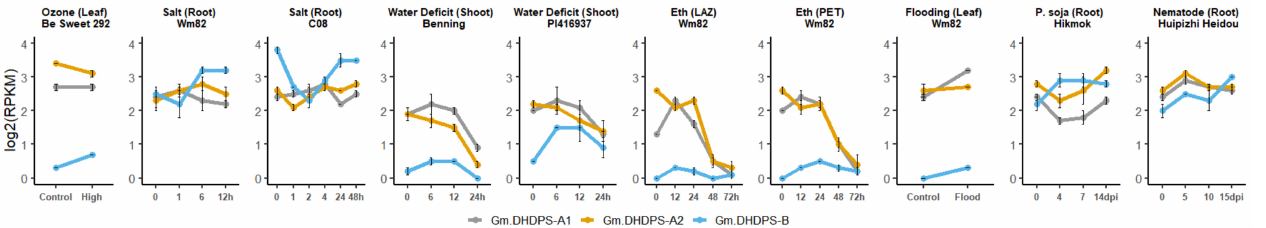
Figure 7. Line graphs of log2-transformed RPKM values for DHDPS for re-analyzed experiments in which at least one DHDPS was significantly up- or downregulated ( p < 0.05). Each graph title consists in short of the treatment, plant tissue and genotype of the experiment. Y -axis represents the RPKM value and each X -axis the treatment in chronological or alphabetical order. Eth = ethylene; LAZ = leaf abscission zone; PET = petiole after LAZ